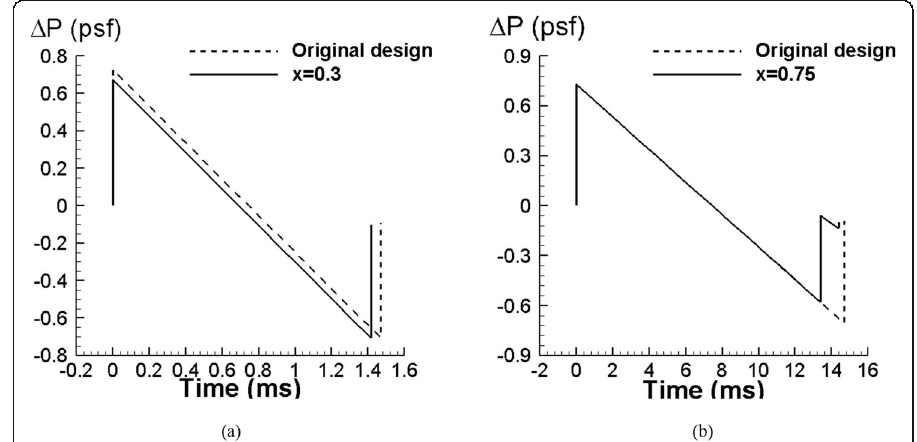
Fig. 6 Ground boom signatures of the baseline and optimized diamond airfoil a with a suction slot at the optimal location and b with an injection slot at the optimal